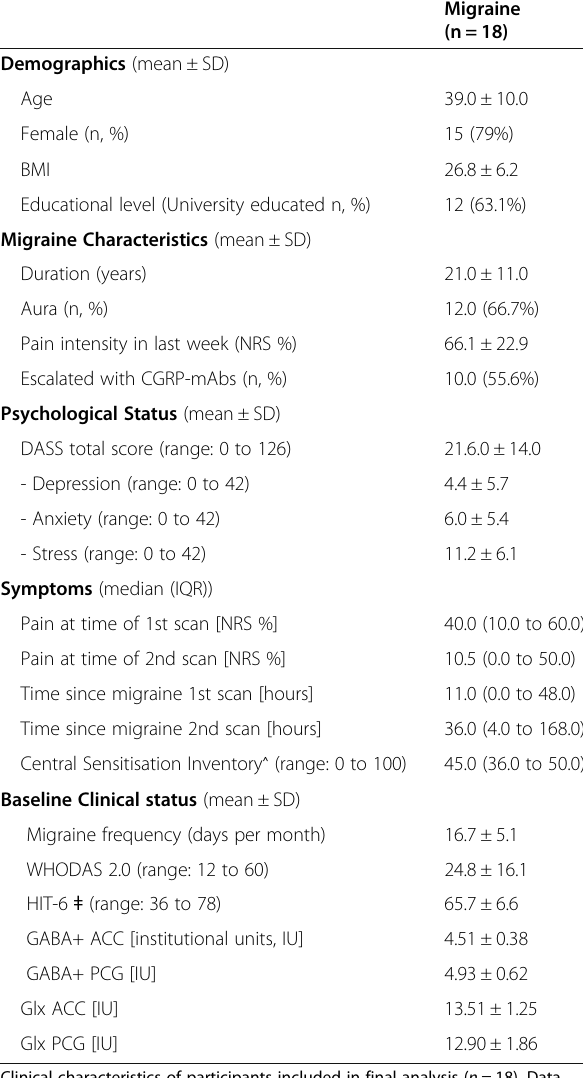
Table 1 Clinical characteristics of